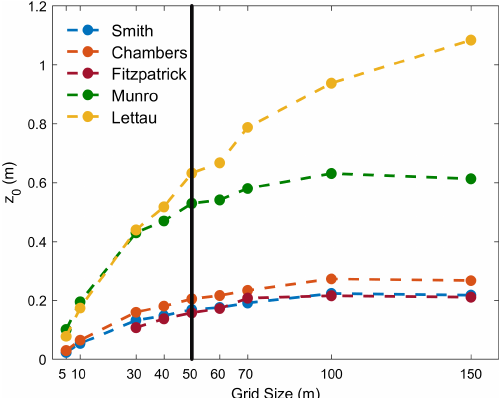
Figure 9. Scale dependency of mean z 0 values for the five applied models and a down-glacier wind direction on Fridtjovbreen with chosen sub-grid sizes from 5 to 150m. The black line indicates the chosen grid size of 50m which incorporates the upper boundary of the average obstacle sizes between 30 and 50m found on all glaciers (see Table